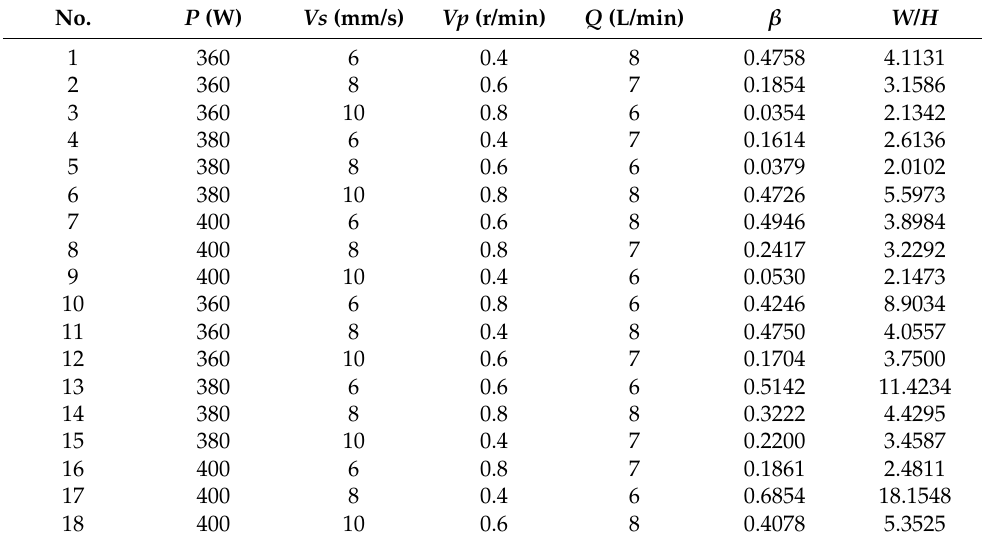
Figure 3. LC morphology of single channel and geometric feature. Table 2. Design and results of the orthogonal experiment.